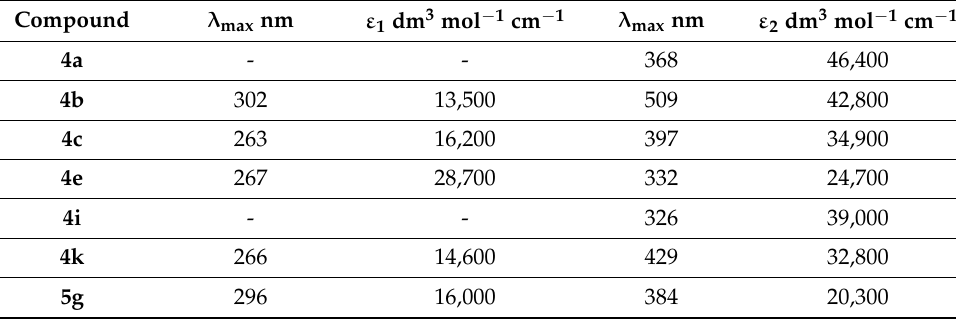
Figure 5. UV – Vis spectra of selected synthesized compounds in MeCN (2 × 10 − 5 M). Figure 5. UV–Vis spectra of selected synthesized compounds in MeCN (2 × 10 − 5 M). Table 3. Photophysical properties of some synthesized compounds. Table 3. Photophysical properties of some synthesized